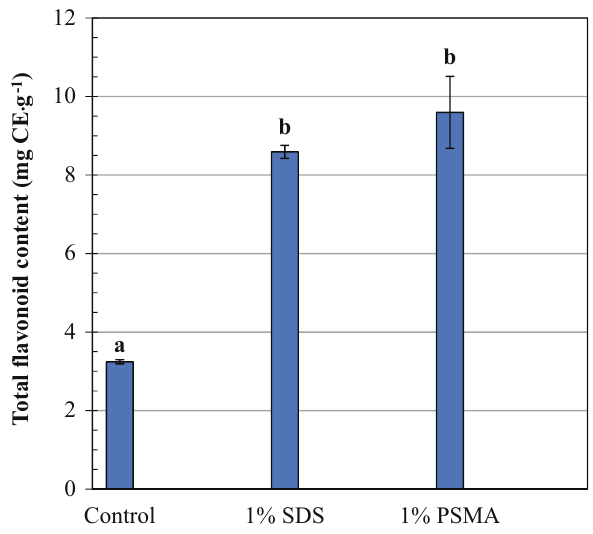
Figure 4: Comparison of the total fl avonoid contents in robusta co ff ee leave extracts obtained by di ff erent extracting systems. Mean values followed by the same letter in a bar chart plot are not signi fi cantly di ff erent at p < 0.05, according to the Duncan ’ s multiple range test.